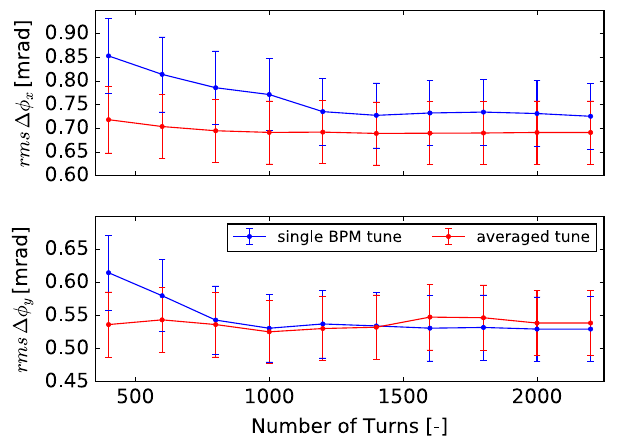
FIG. 2. Simulated rms phase-advance error computed from single-particle simulations of the ESRF storage ring lattice as a function of the number of turns used for the analysis in two cases where the betatron tune is calculated from a single BPMs or averaged over the set of all BPMs (realistic noise has been added to BPM TbT data). The initial displacement of 0.55 mm (horizontal) and 0.15 mm (vertical) at β x ¼ 38 m and β y ¼ 2 . 9 m (initial actions: J x 0 ¼ 4 . 0 × 10 − 9 m and J y 0 ¼ 3 . 9 × 10 − 9 m).